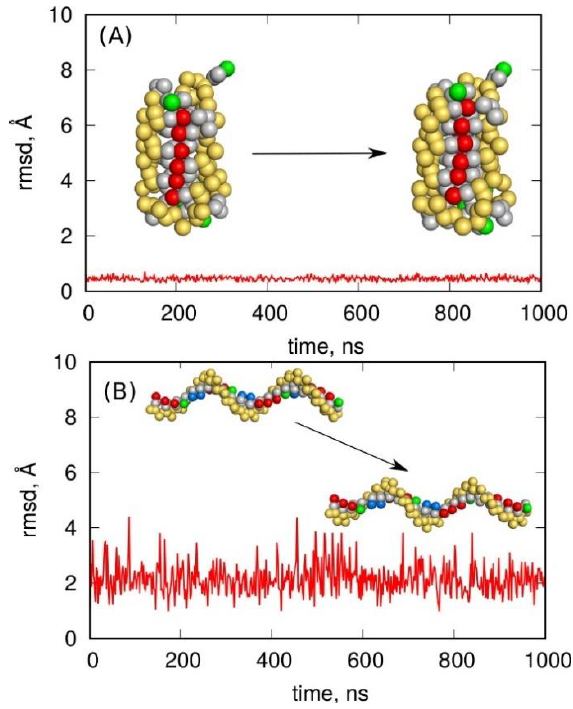
Figure 9. ( A ) The rmsd for the i-motif structure obtained using the stiff elastic network approach in a Martini coarse-grained model. ( B ) The rmsd for the same sequence of single-stranded DNA but starting from the ideal helix/coil form. The snapshots on the left show the starting/reference structures, while the snapshots on the right show the final structures at the end of the simulations.